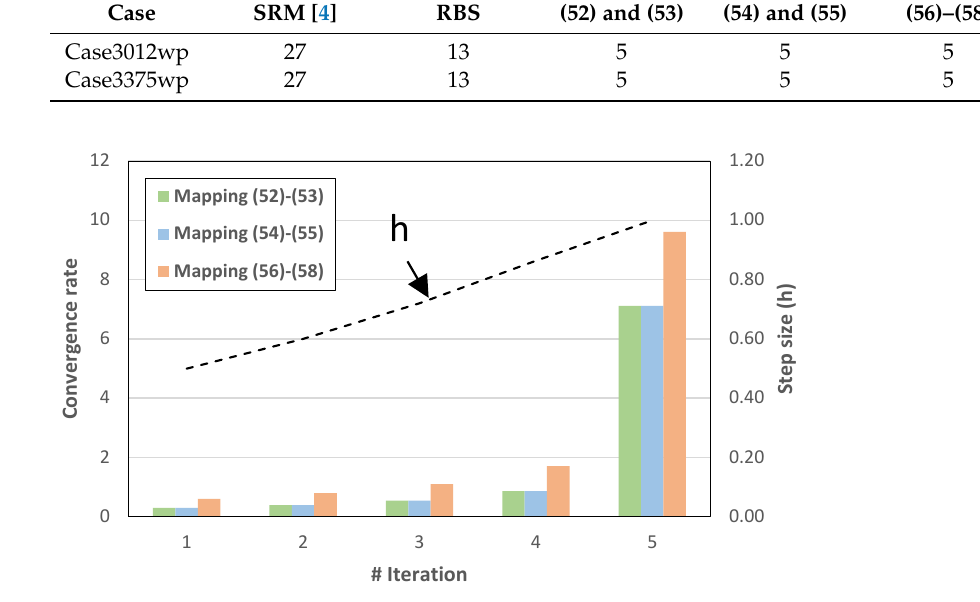
Figure 3. Step size and convergence rates of 4OJ and the developed methods for the ‘case3012wp’.